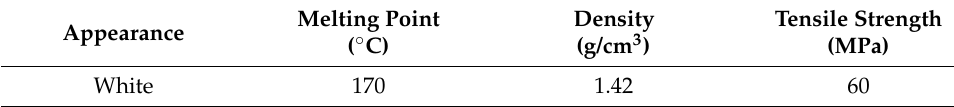
Table 2. Properties of PVC